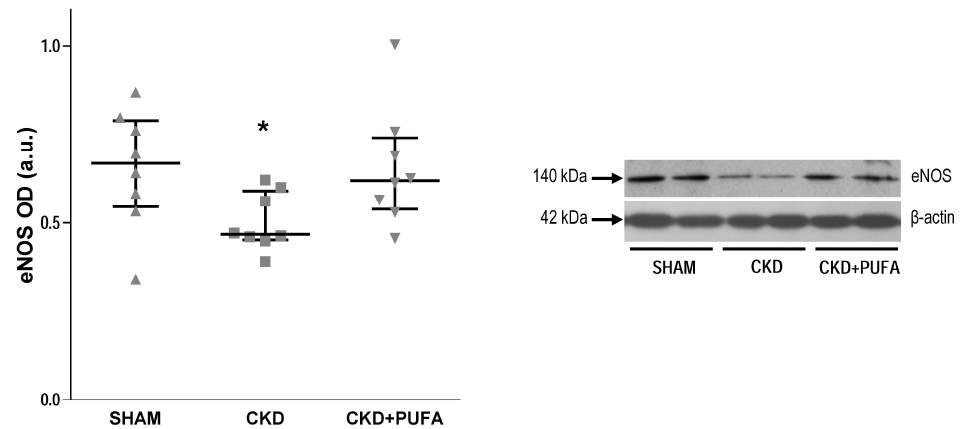
Figure 3. Densitometric analysis of the expression of eNOS protein (140 kDa) in aortas from sham-operated (SHAM), 5/6 nephrectomized rats fed with standard diet (CKD) and fed with n -3-PUFA enriched diet (CKD + PUFA), with representative blot. Data represent mean value of 8 animals from each group. In aortas from 5/6 nephrectomized rats fed with standard diet, eNOS expression was lower (* p < 0.05) compared to that in vessels from sham-operated and from 5/6 nephrectomized rats fed with n -3 PUFA enriched diet. OD: Optical density; a.u.: Arbitrary units. Median and interquartile range.